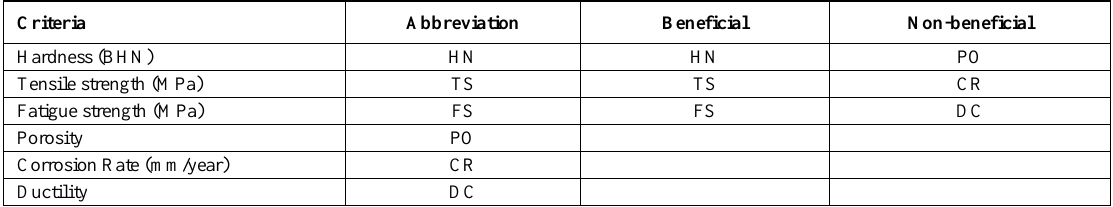
Table 1. Nomenclature of the